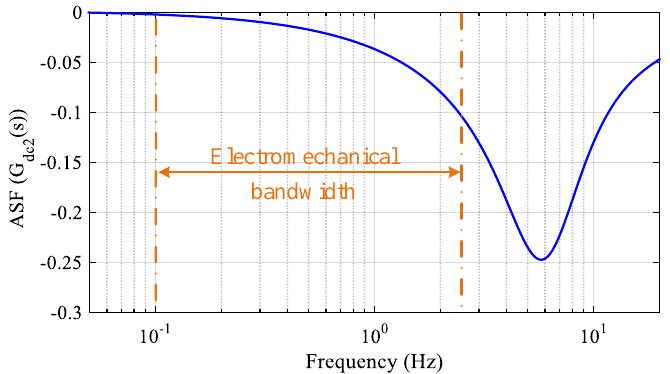
Figure 5. Amplitude sensitivity function (ASF) of G dc 2 ( s ) with respect to U ref .